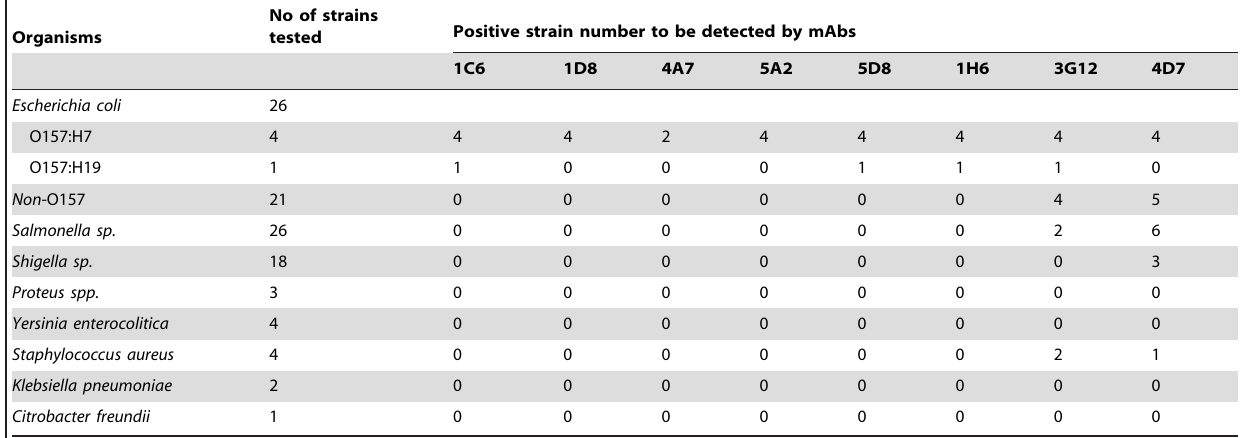
No of strains Organisms tested Positive strain number to be detected by mAbs